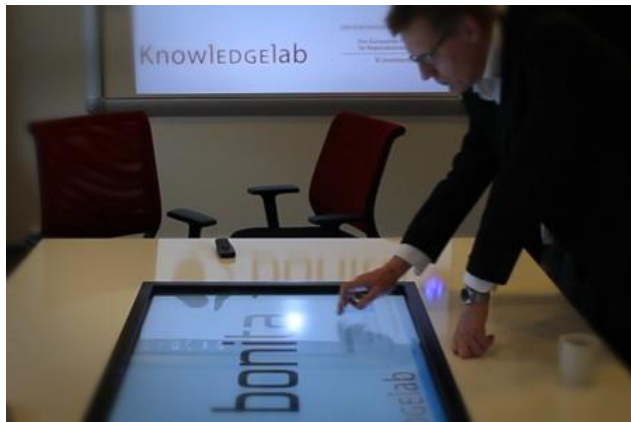
Fig. 5. Multi-touch table in the showroom at South Denmark University.